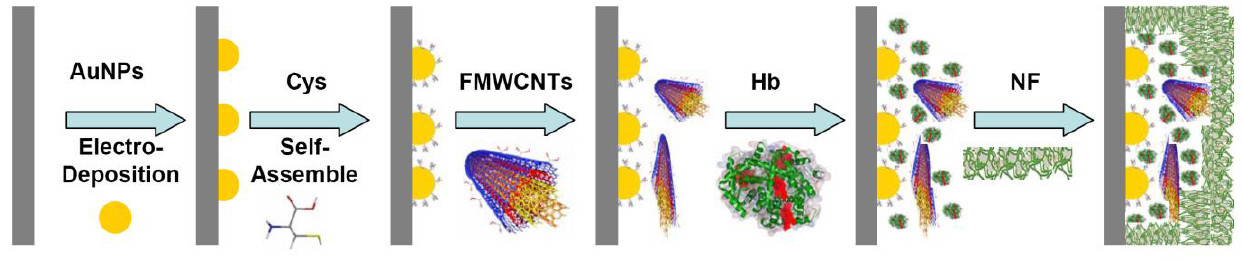
Figure 1. Preparation process of functional membrane modified glassy carbon (GC)